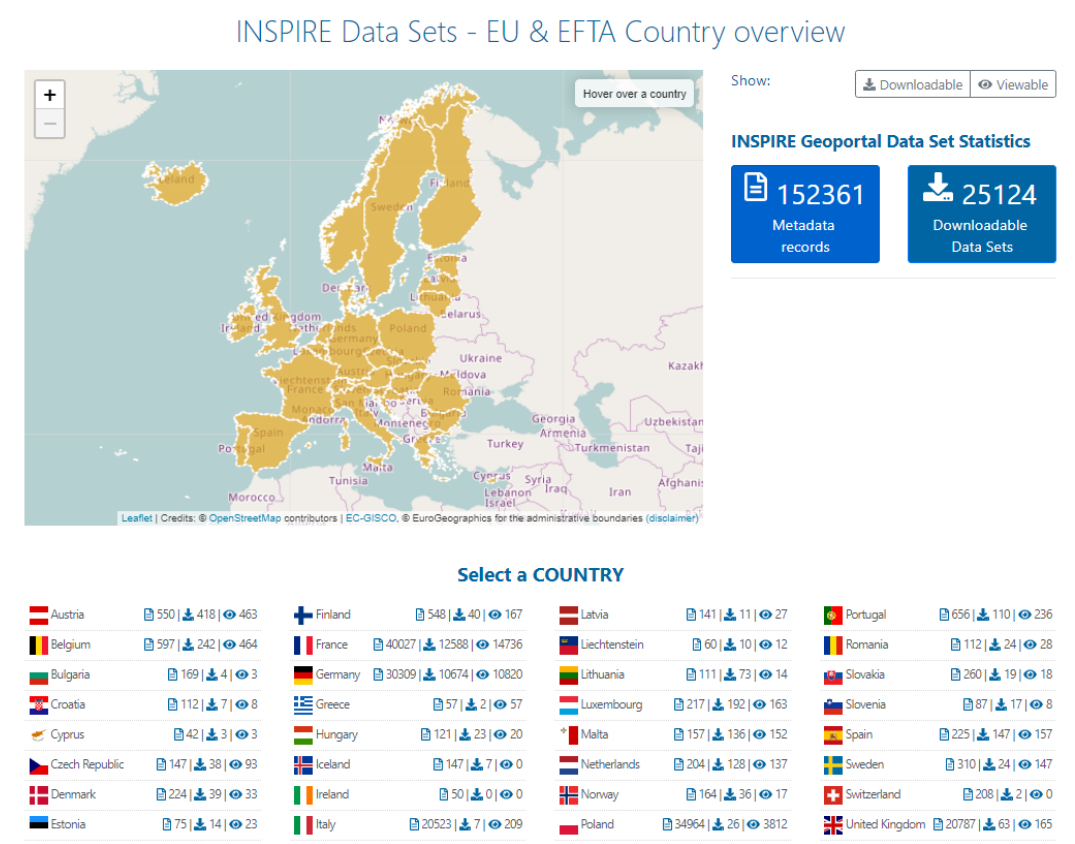
Figure 1. Data availability in the European INSPIRE Geoportal as of October 2019. Source: